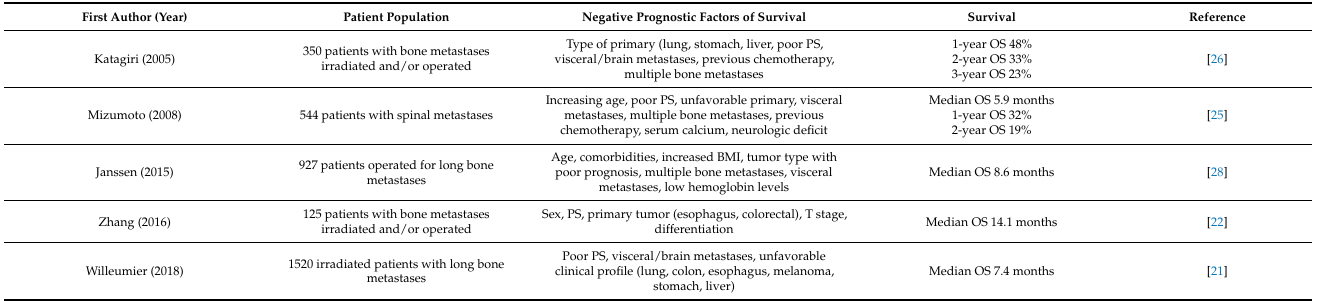
Table 6. Studies assessing prognostic factors associated with overall survival with bone metastases.